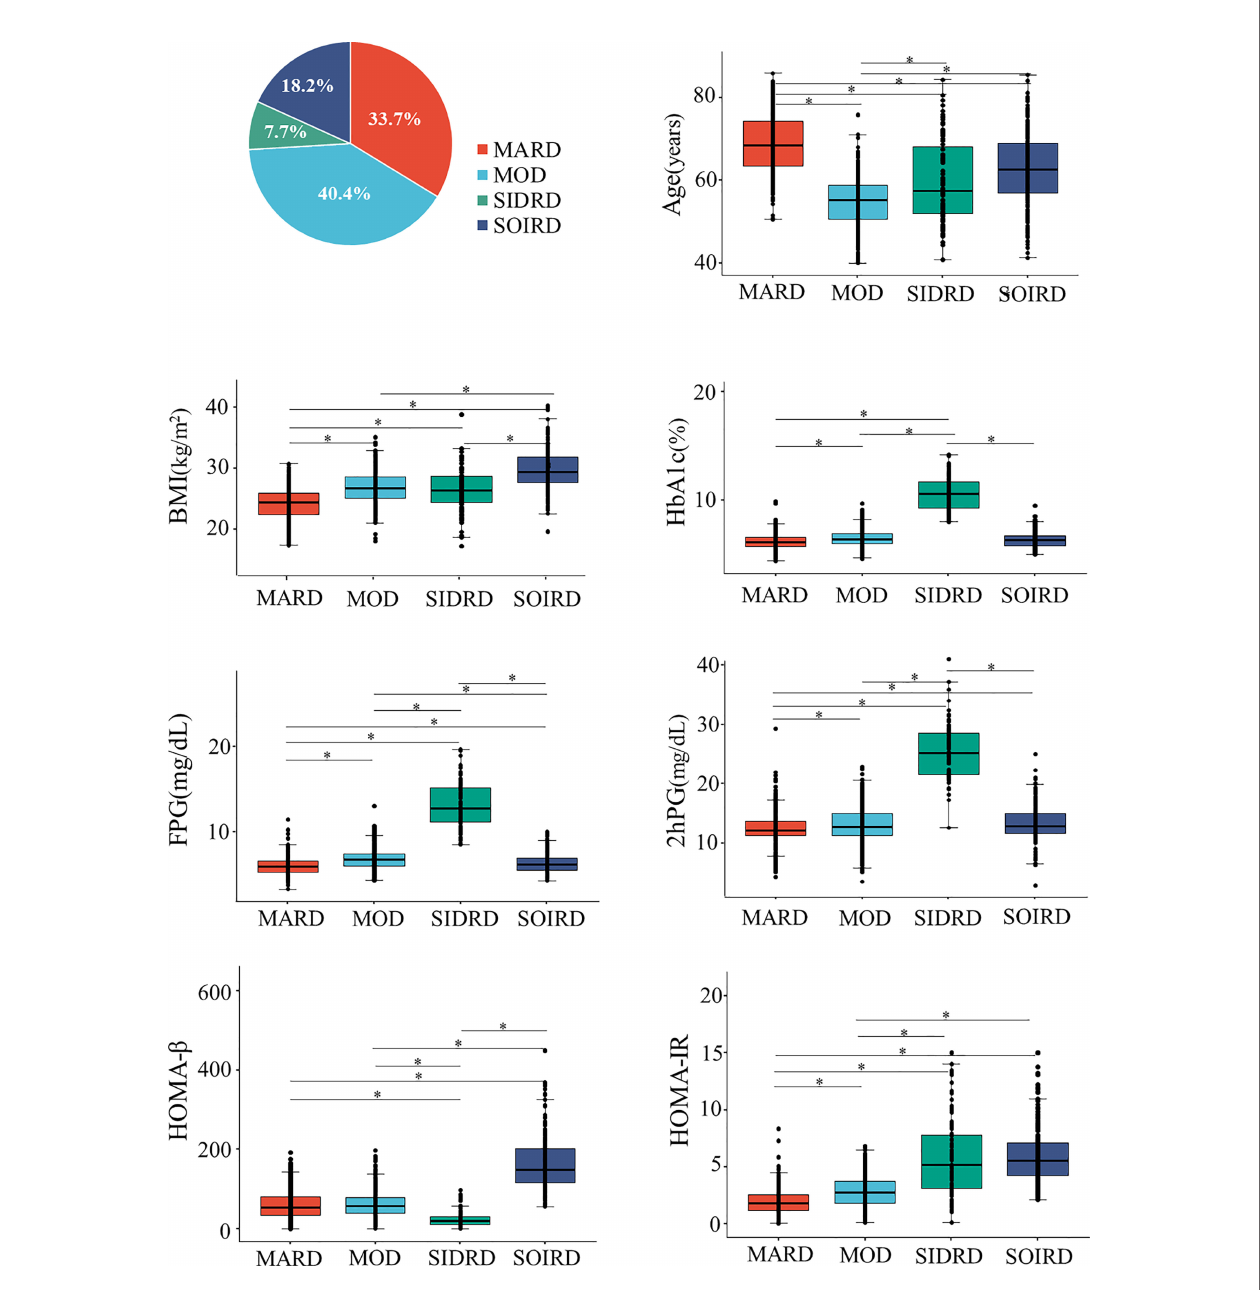
FIGURE 1 | Distributions and cluster characteristics at baseline. *The differences between clusters were compared by using t tests, and the Bonferroni correction was used to adjust the statistical signi fi cance level ( P = 0.05/6). MARD, mild age-related diabetes; MOD, mild obesity-related diabetes; SIDRD, severe insulin- de fi cient and insulin-resistant diabetes; SOIRD, severe obesity-related and insulin-resistant diabetes; BMI, body mass index; HbA1c, hemoglobin A1c; FPG, fasting plasma glucose; 2hPG, 2 hours postprandial blood glucose; HOMA- b , homoeostatic model assessment estimates of b -cell function; HOMA-IR, homoeostatic model assessment estimates of insulin